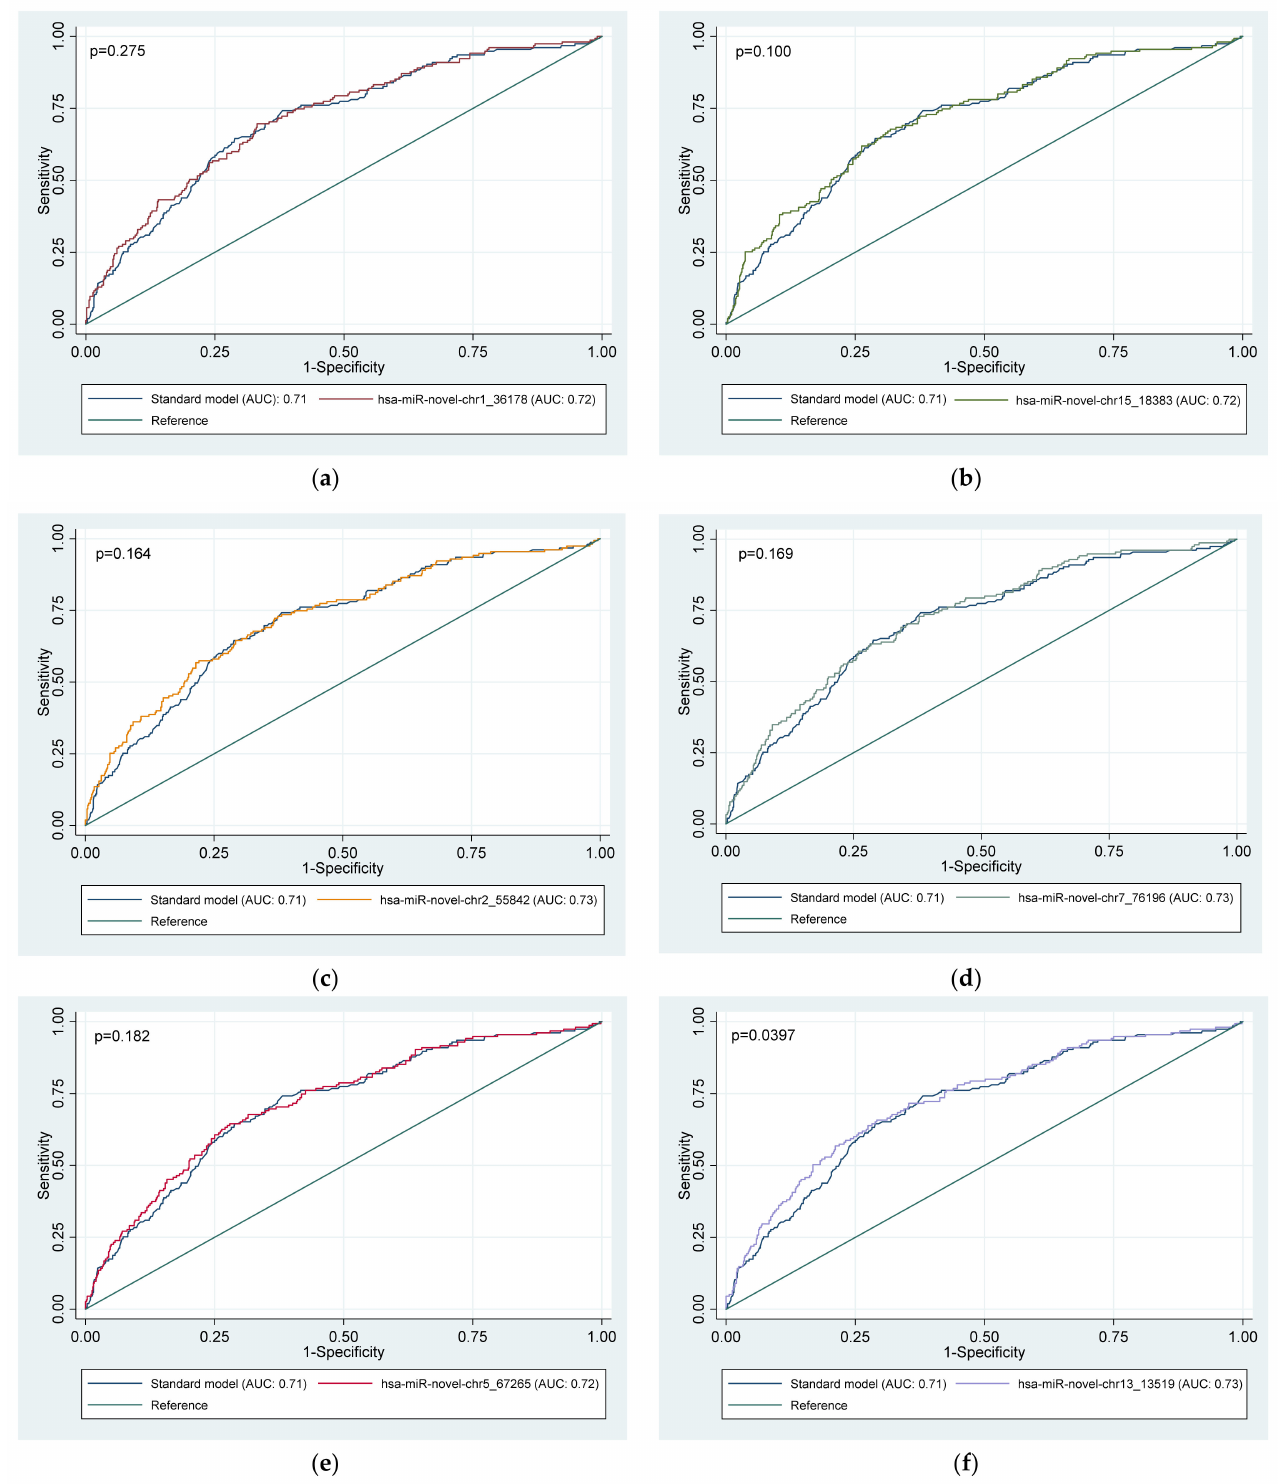
Figure 3. Area under the receiver operator characteristic (ROC) curves (AUC), illustrating the diagnostic advantage of six ( a – f ) novel whole blood miRNAs to predict CKD in a group of high-risk individuals above that of conventional risk factors. Standard model: age + gender + smoking status + drinking status + diabetes status + hypertension status. Model for each miRNA separately: miRNA + age + gender + smoking status + drinking status + diabetes status + hypertension status. miRNA,